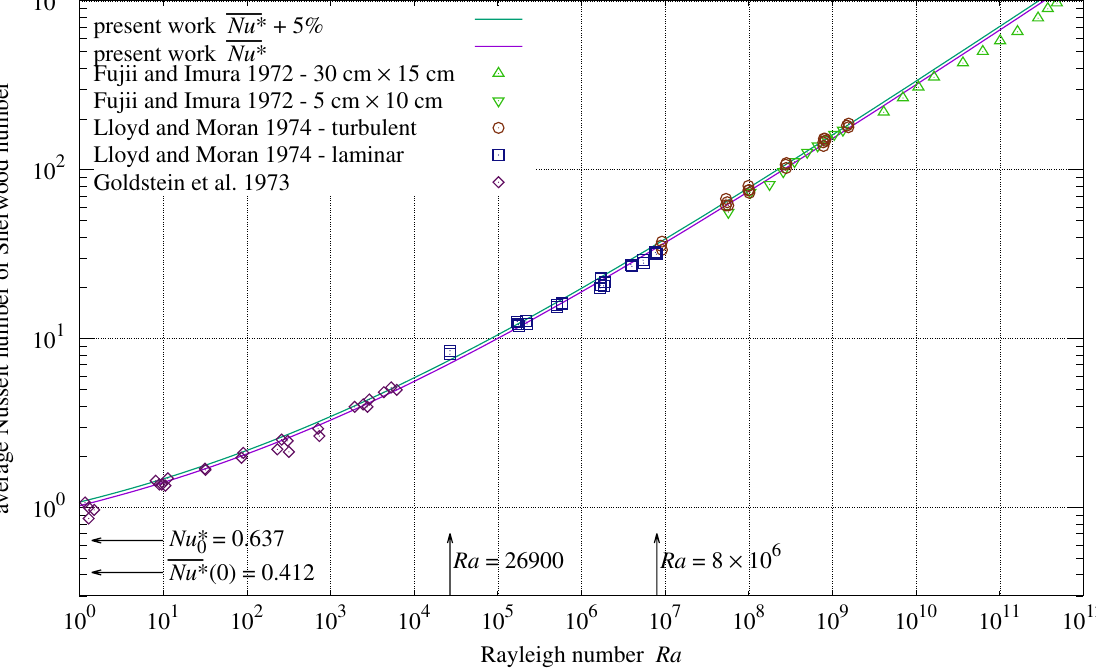
Figure 3. Upward convection heat or mass transfer from horizontal plate. Ra ≈ 26,900 was the smallest Ra measured by Lloyd and Moran; the next smallest Ra = 171,750 was 6.4 times larger. Range extremes are often the most susceptible to measurement bias. Having excesses several times larger than 5%, the points at Ra ≈ 26,900 should be excluded as